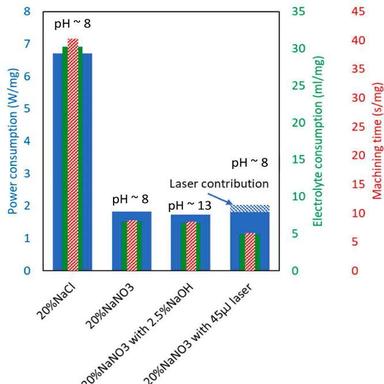
Power and resource consumption analysis for processing NbC–Ni cermet with ECM in different electrolytes and LECM in 20% NaNO3.